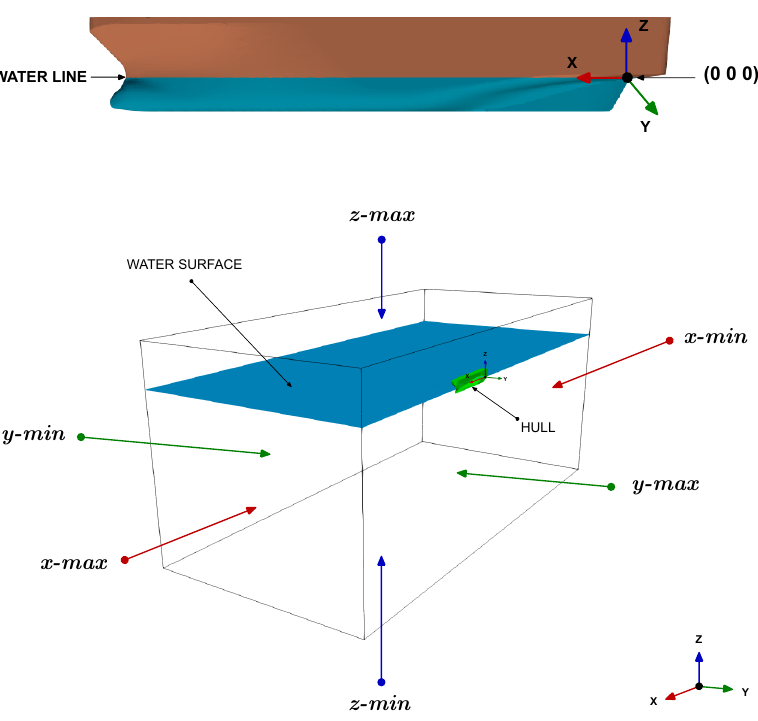
Figure 8. Top: coordinate system. Bottom: computational domain and boundary